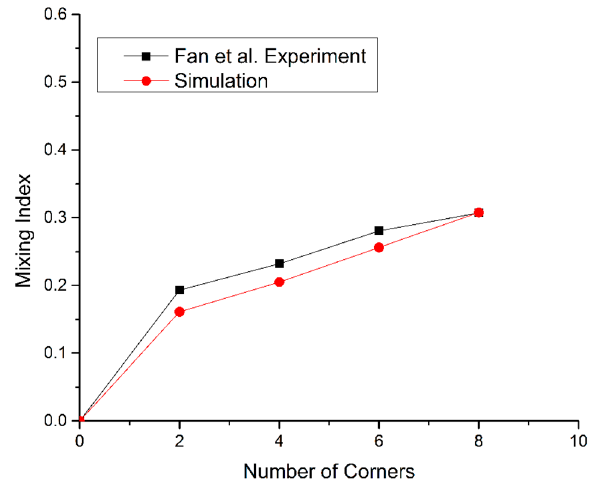
Figure 3. Comparison of the simulation and experimental results.